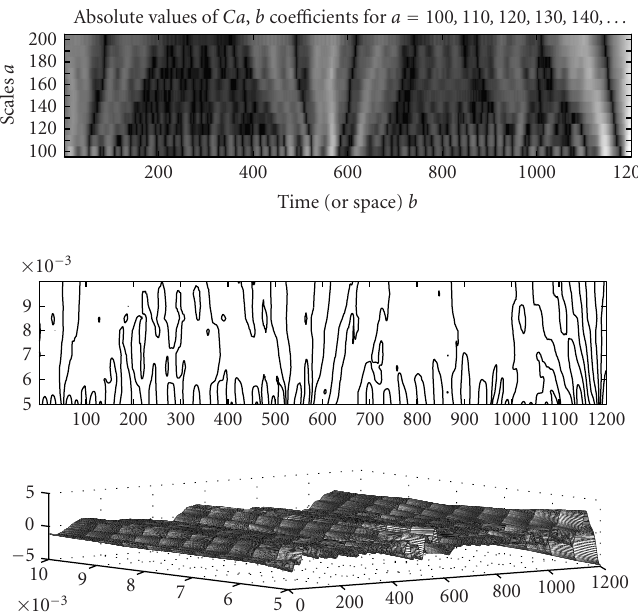
Figure 3.7. Continuous wavelet transform with